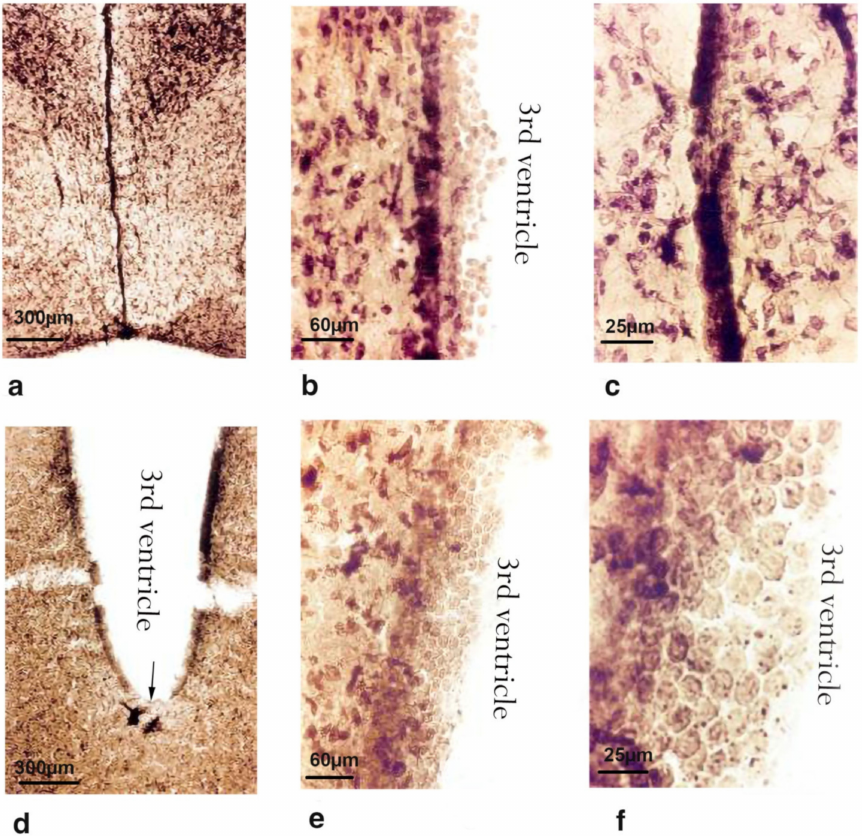
Figure 4. Microphotographs of rats’ brain sections of the 3rd ventricle: ( a – c ) control animals; ( d – f ) animals under the influence of bilateral single i.c.v. administration of A β (1-42). Magnifi- cation: 25 × ( a , d ); 160 × ( b , e ); 400 × ( c ); 1000 × ( f ).